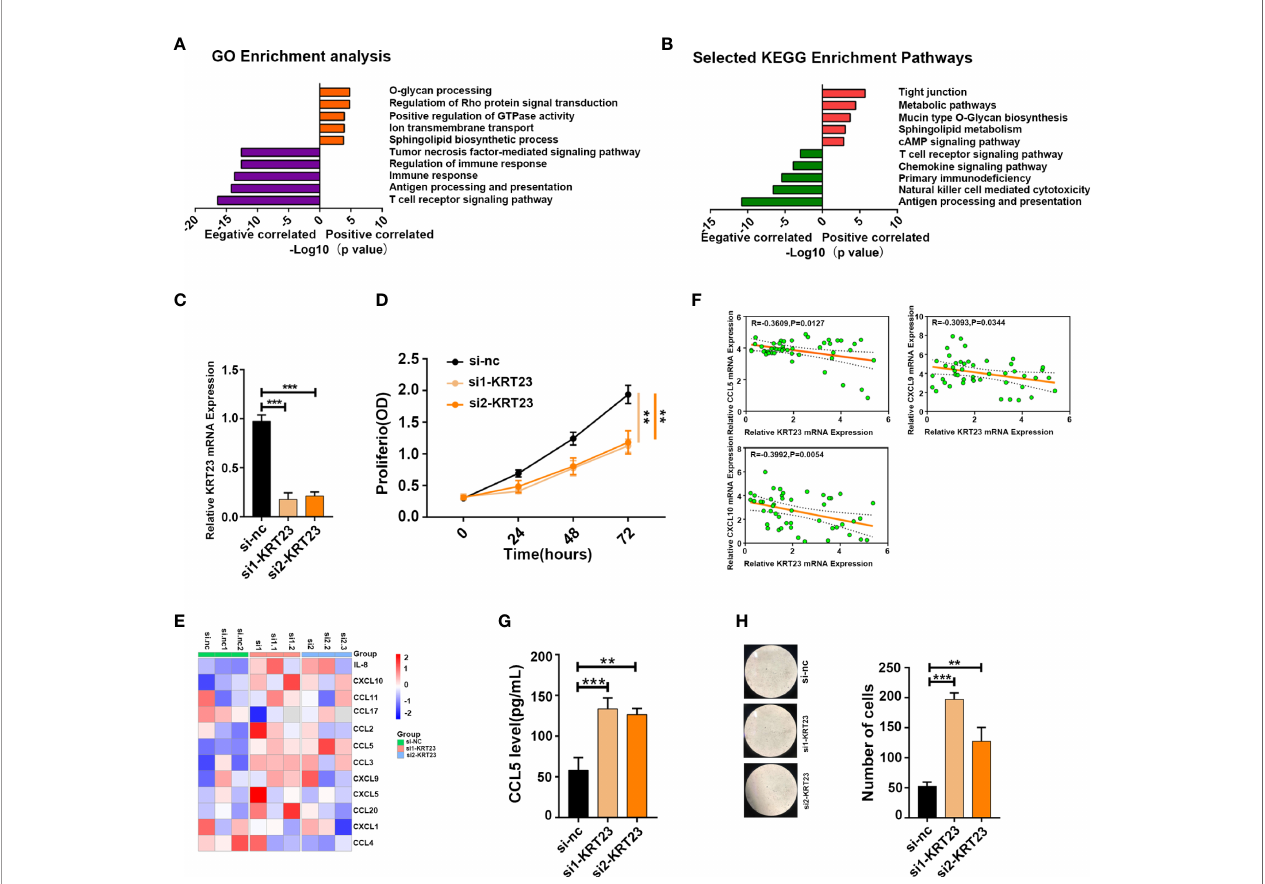
FIGURE 6 | KRT23 promotes CD8 + T cell recruitment. (A, B) GO and KEGG analysis of KRT23-related genes. (C) qPCR analysis shows the knockdown ef fi cacy of KRT23. (D) Proliferating rate of tumor cells with knockdown of KRT23. (E) The heatmap shows the concentration of cytokine and chemokine secreted by tumor cells with knockdown of KRT23. (F) Correlation of KRT23 and CCL5, CXCL9, and CXCL10 in tumor tissues of CC. (G) ELISA shows the CCL5 secretion by tumor cells with knockdown of KRT23. (H) Number of CD8 + T cells recruited by conditioned medium derived from tumor cells with knockdown of KRT23. ** p ≤ 0.01, *** p ≤